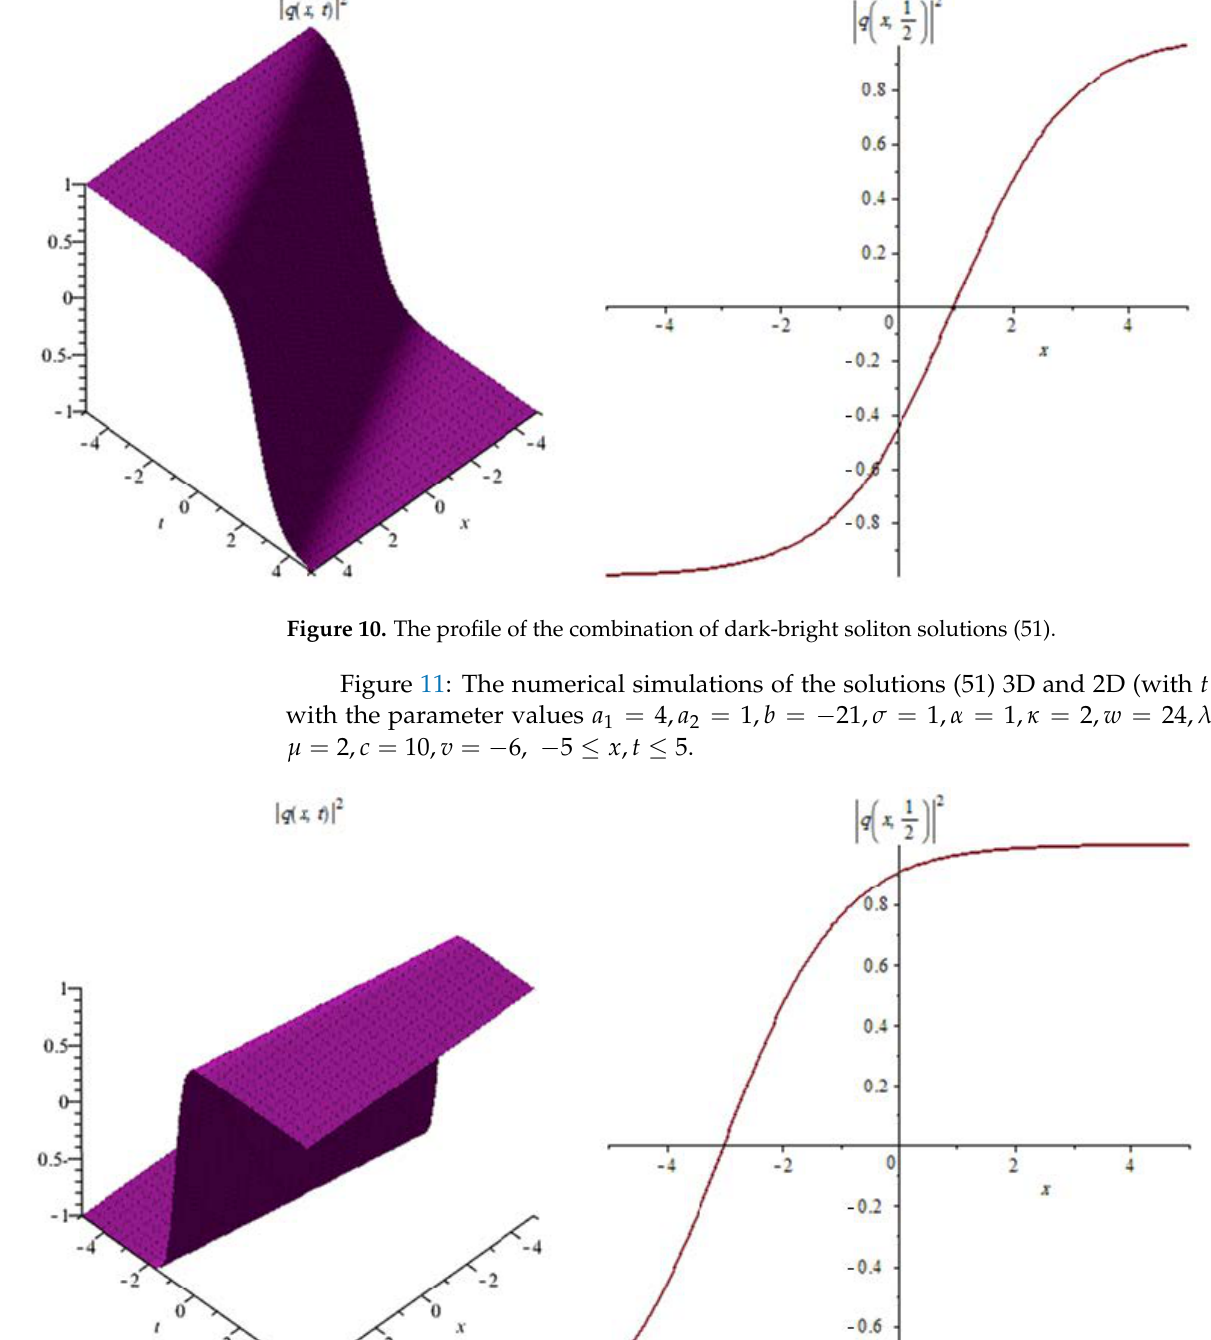
Figure 11. The profile of the combination of dark-bright soliton solutions (51). Figure 12: The numerical simulations of the solutions (51) 3D and 2D (with t = 1 with the parameter values a 1 = 6, a 2 = 1, b = 16, σ = 2, α = 1, κ = 2, w = 30, λ = 2, − µ = 2, c = 10, v = 6, 5 5. x , t − ≤ ≤